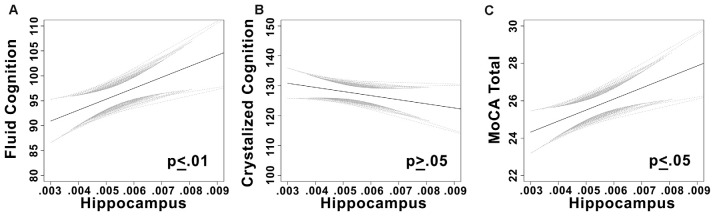
(A) Plots the linear relationship between fluid cognition and hippocampal volume. (B) Plots the linear relationship between crystalized cognition and hippocampal volume. (C) Plots the linear relationship between Montreal Cognitive Assessment (MoCA) total score and hippocampal volume. Confidence bands are 95% confidence intervals of the regression line.